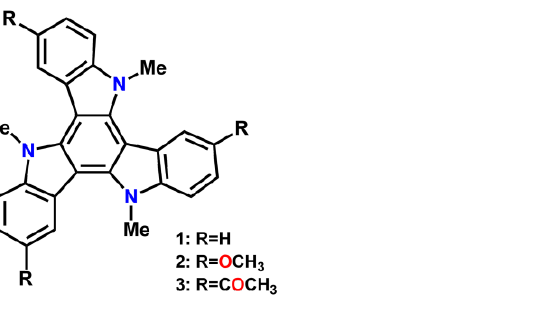
Figure 1. Chemical structures of the three triindole-based systems 1 – 3 reported in this work.